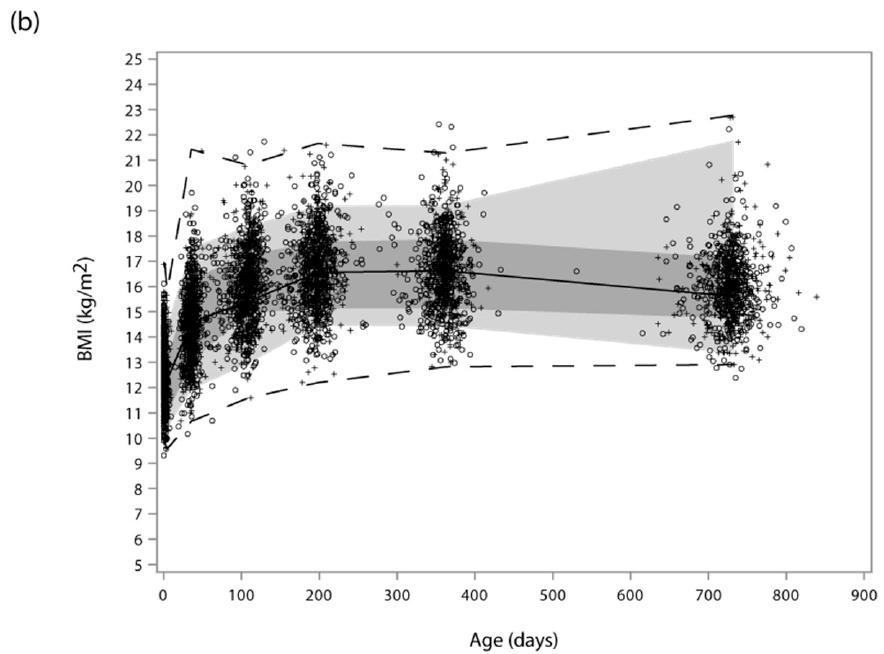
Figure 1. Functional boxplot of child body mass index (BMI) across ages at measure overlaid with scatter plots at each age in the SPATZ ( a ) and UBCS ( b ) cohorts. Scatter plots represent children with complete ( + ) BMI data used to calculate the functional boxplot and children with incomplete (O) data at one or more measurement periods. (Measurement periods were each collapsed to the average measurement period time for functional boxplot calculation, which is why the functional boxplots exhibit kinks at the center age of each scatter and end at the center age (approximately 750 days) of the last measurement. The solid black line represents the median curve of the functional boxplot. The dark and light grey bands are the central 10% and 50% regions, respectively; the latter corresponding to the interquartile range in a usual boxplot. The dashed lines indicate the nonoutlying envelopes determined by the 1.5 times the 50% central region rule (like the whiskers in a usual boxplot), which in both images correspond to the minimum and maximum since no outliers were detected.).